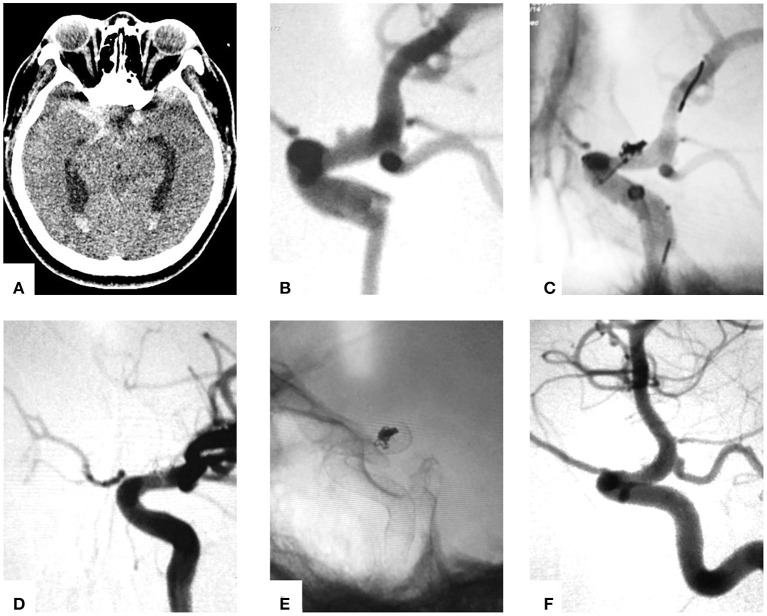
Images of the typical cases. (A) CT scan showed symmetric suprasellar cistern SAH and hemorrhage in lateral ventricles. (B) Cerebral angiograms obtained immediately pre-embolizaton. (C) PED semi-deployed coiling. (D) and (E) Post-treatment DSA. (F) DSA follow-up 6 months after treatment.